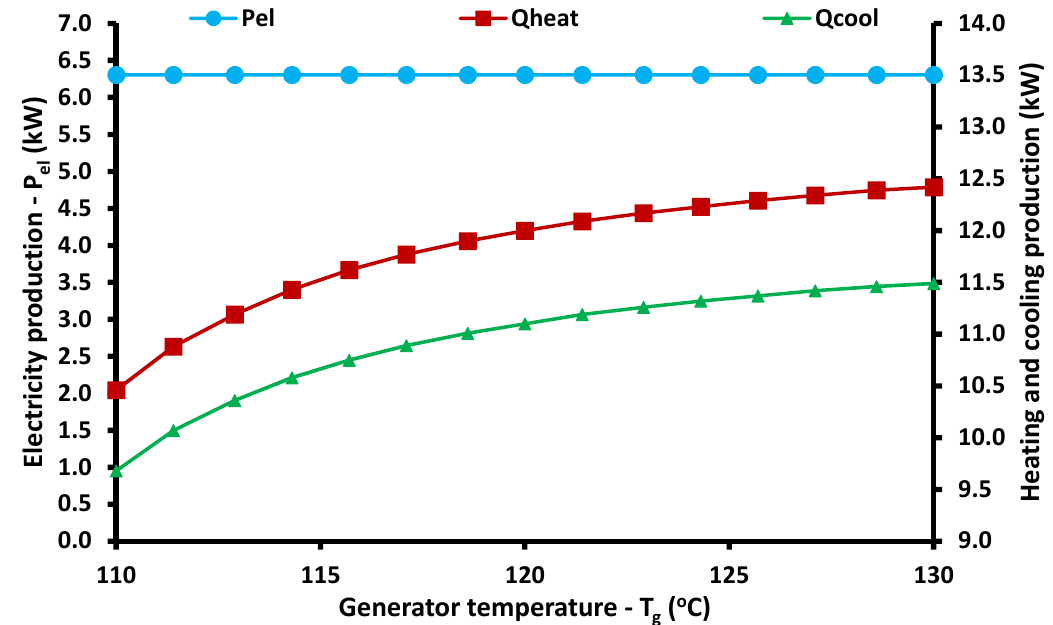
Figure 14. Electricity, heating, and cooling for different generator temperature levels.